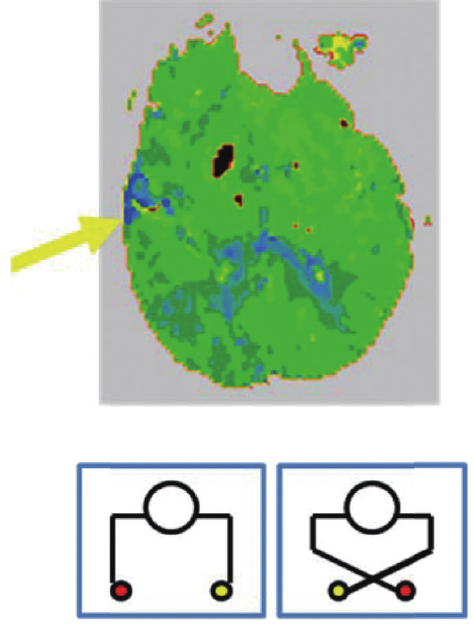
Fig. 2. Top Panel. Perfusion Weighted Image showing 6 sec delay in the time to peak arrival of contrast (which has been demonstrated to be associated with tissue dysfunction; see Shirani et al. [46], also Sobesky et al. [45]) in superior temporal cortex in a patient with left canonical body extinction. Lower Panel. Schematic representation of left canonical body extinction. The yellow hand is extinguished in both the uncrossed (left) and crossed (right)